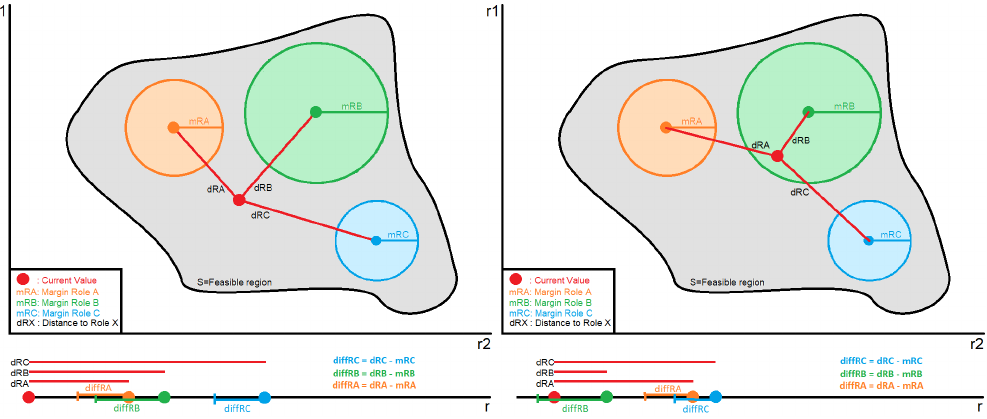
Figure 4. Role assignment to